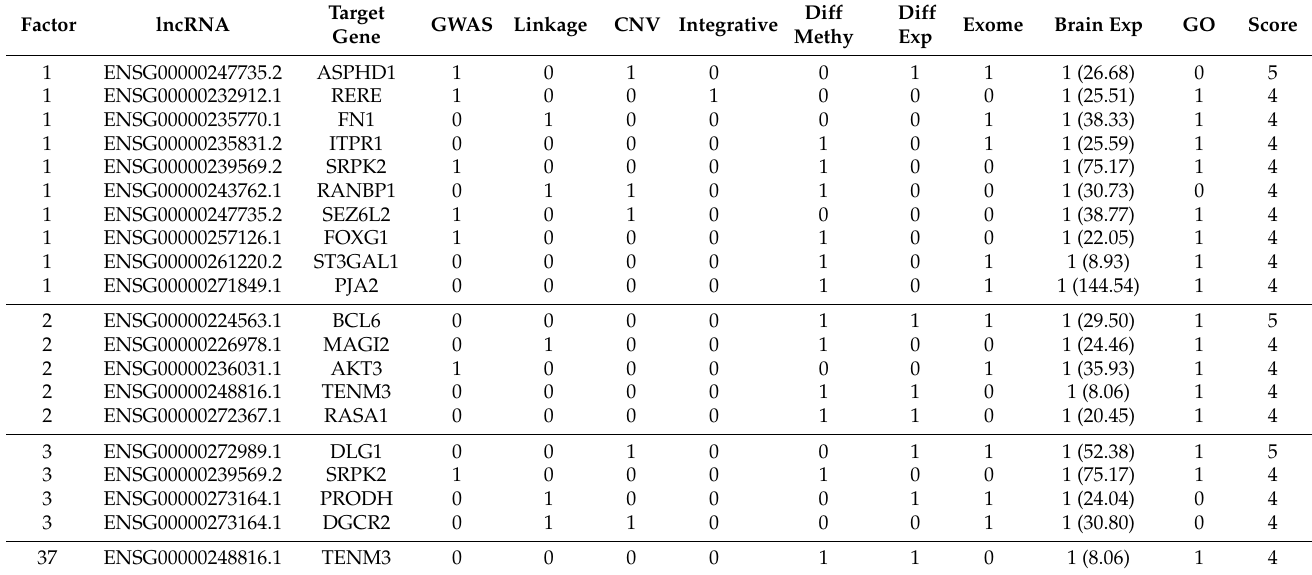
Table 2. Target genes in lncRNA factors with high supportive